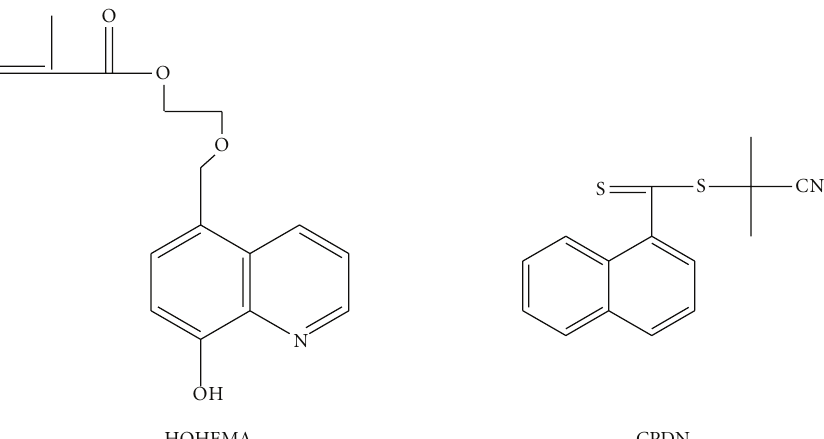
Scheme 1: The chemical structures of 2-((8-hydroxyquinolin-5-yl)methoxy)ethyl methacrylate (HQHEMA) and 2-cyanoprop-2-yl 1-dithi- onaphthalate (CPDN).